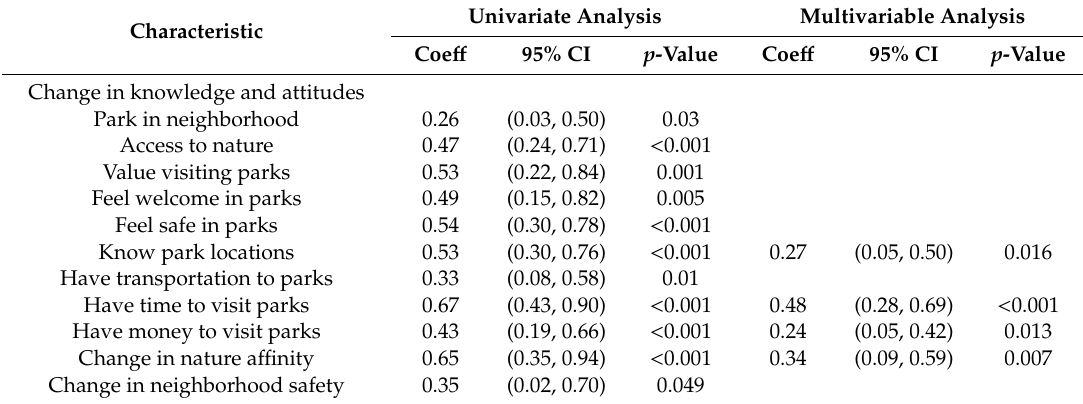
Table 2. Change in the number of park visits per week over baseline, one and three months compared with reported changes in knowledge, attitudes, and access after receiving a park